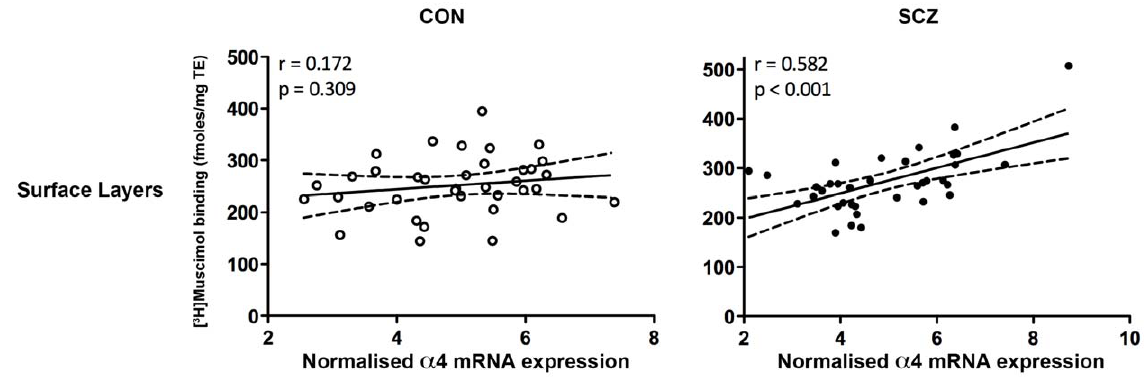
Figure 4. Correlations of [ 3 H]Muscimol binding and a 4 mRNA subunit expression level in the superficial layers of the DLPFC of control (CON) (n=37) and schizophrenia (SCZ) (n=37) cases.